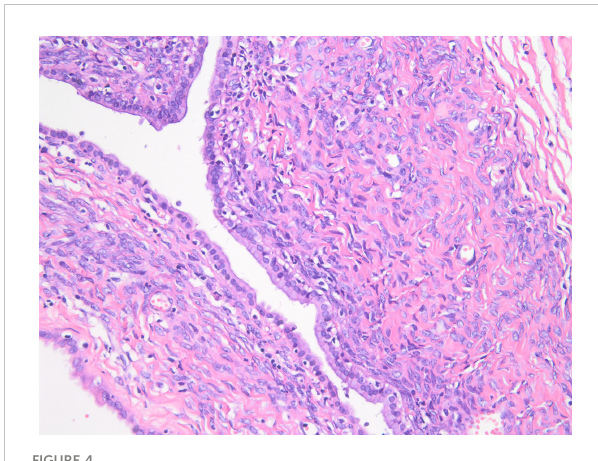
FIGURE 4 Microscopic examination of the resected specimen showing mucinous cystic neoplasm with low-grade intraepithelial